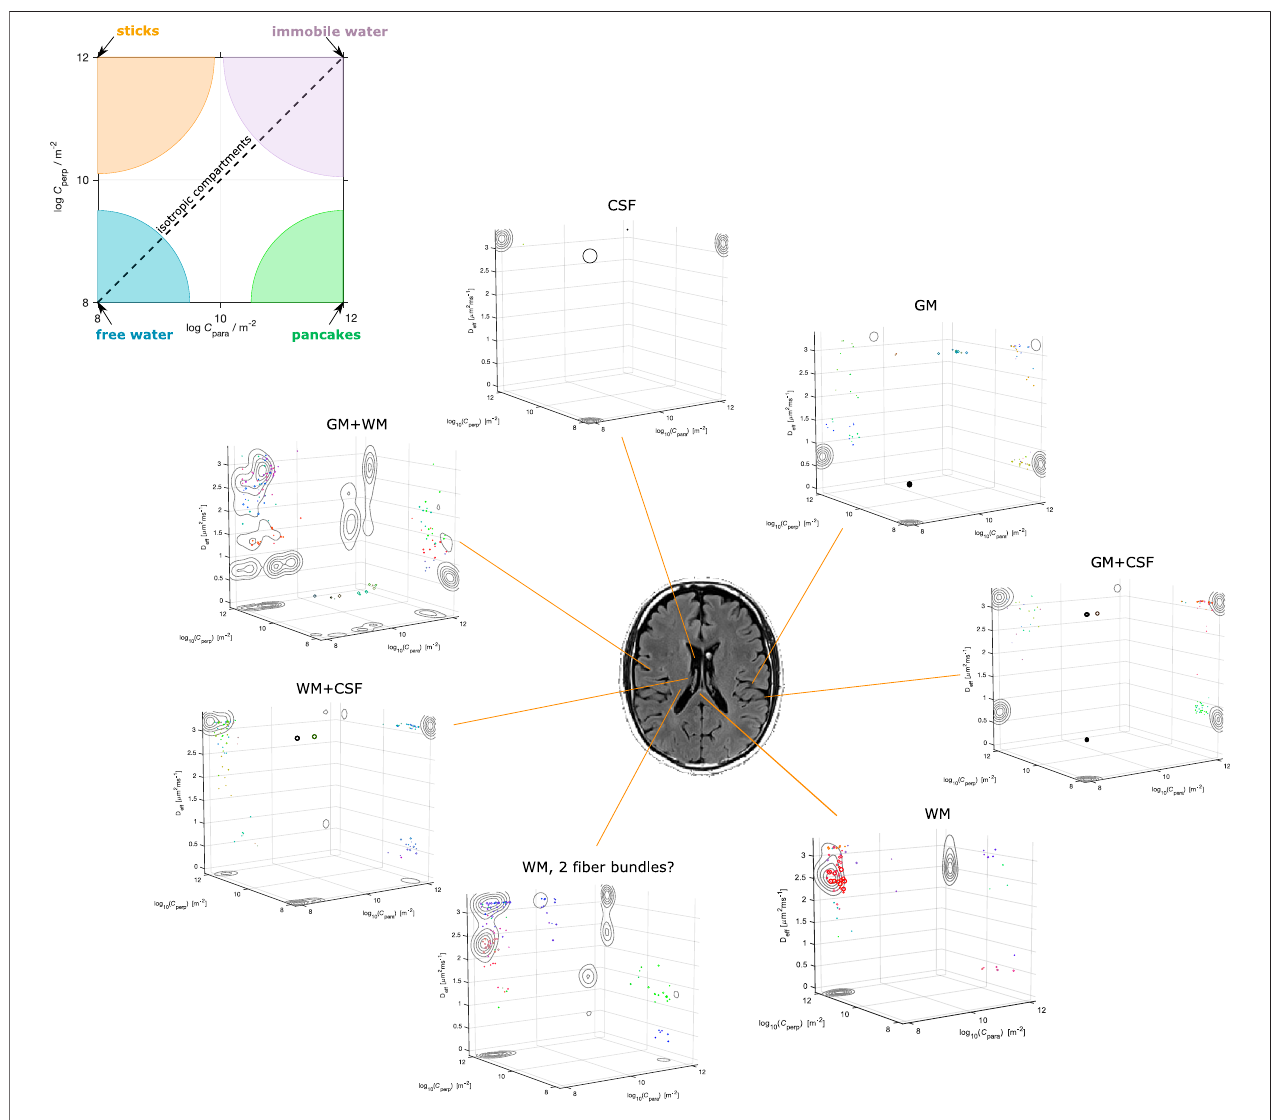
FIGURE 3 | Example results of inverting Eq. 11 on real data collected with LTE, PTE, and STE waveforms [32]. The panel on top shows a bird ’ s eye view on the geometryplane,andhowtoassociatethelocationofpointstoashapeaccordingtotheC para andC perp coordinates.Thecontoursinthe3Dplotshowtheprojectionsof the pores ’ clusters onto the various 2D planes.